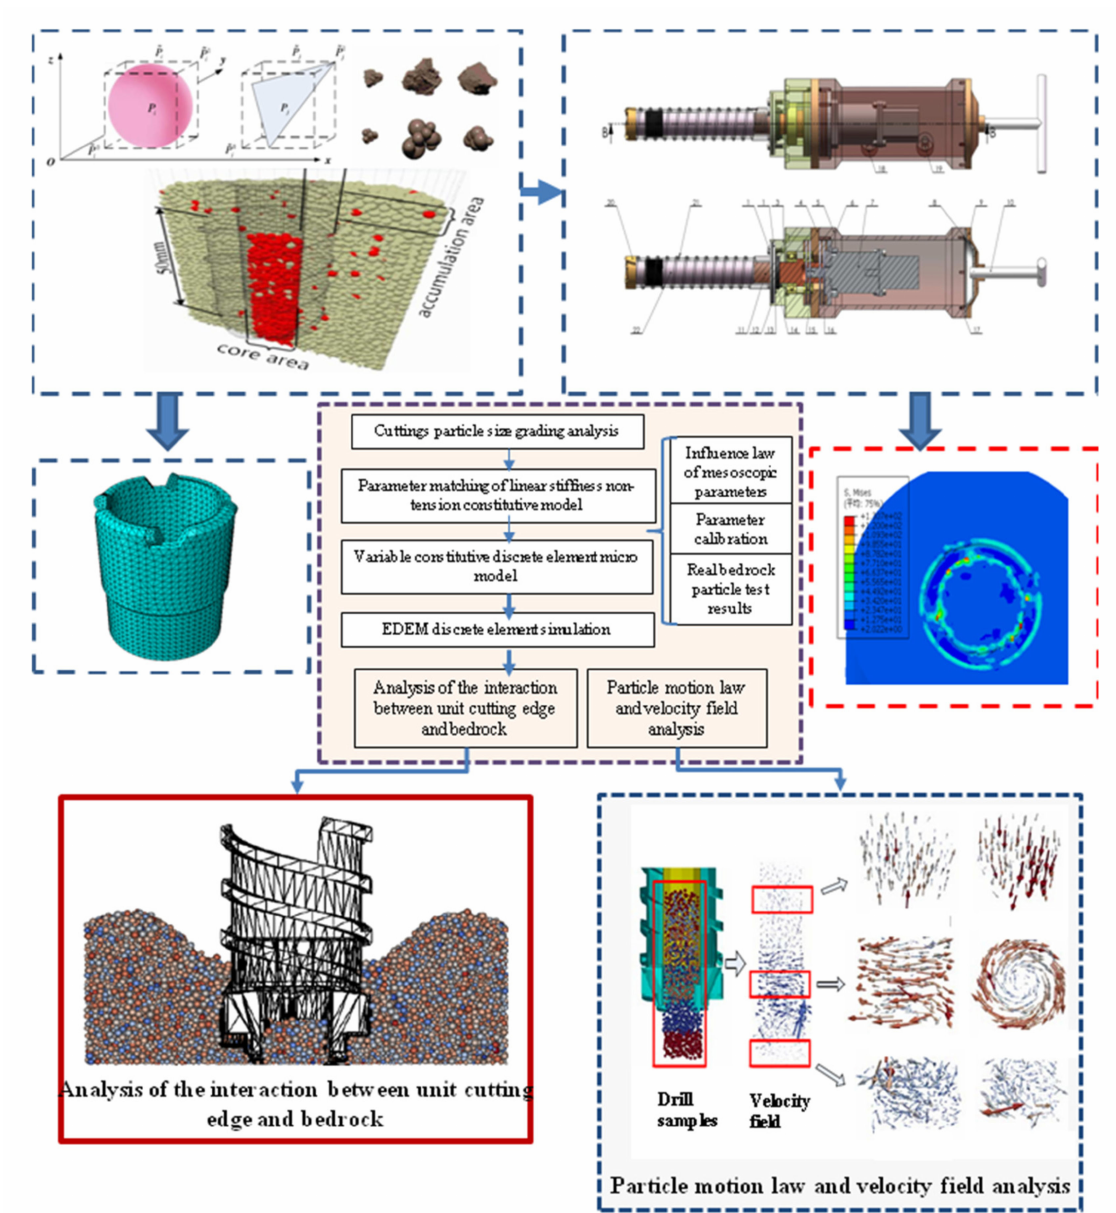
Figure 8. Analysis of the deep-sea drilling method described in this study using the discrete element